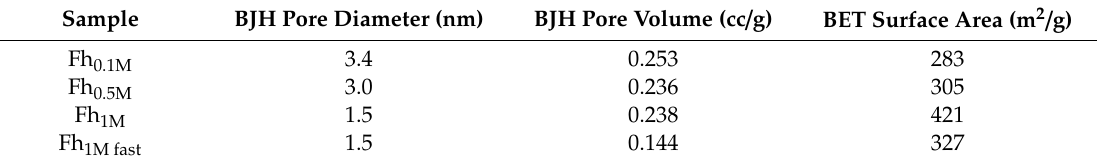
Table 2. Specific surface areas obtained by the Brunauer Emmett-Teller (BET) equation fit for N 2 gas adsorption isotherms of the Fh samples, synthesized from different reagent concentrations and times of synthesis: 0.1 M, 0.5 M, 1 M and 1 M fast. Pore diameters and pore volume from BJH analysis are reported too.